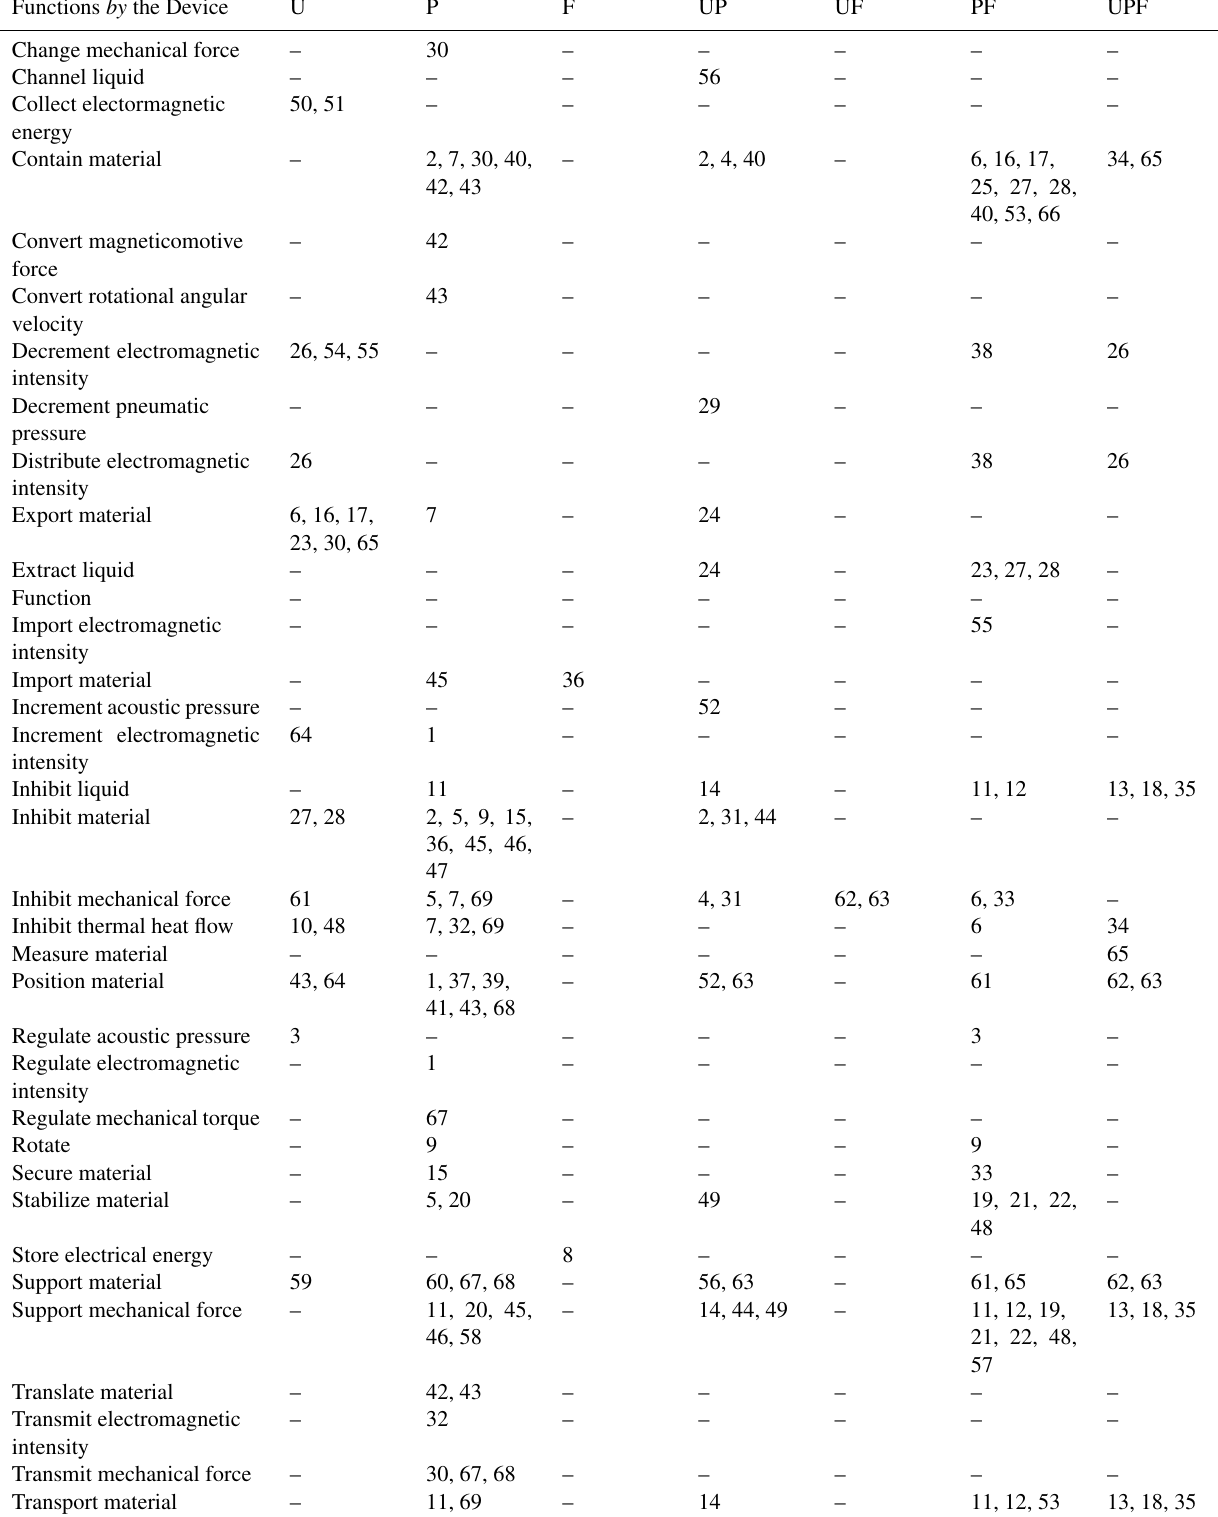
Table 4. We list each device’s number in rows corresponding with the functions performed by the device and columns of its corresponding fold states. See Table 2 for device numbers and references. Functions are labeled using the functional basis developed by Hirtz et al. (2002). Functions by the